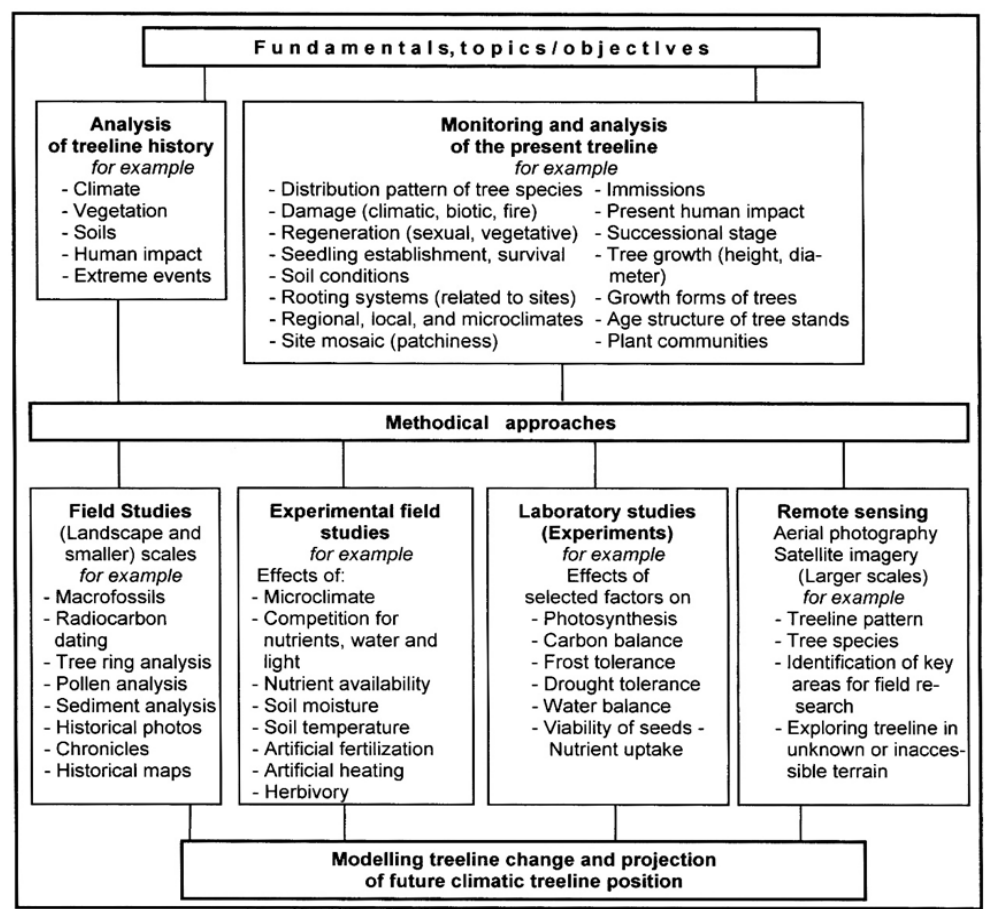
Figure 6. Fundamentals, topics, and objectives of modelling treeline (modified from [2]).